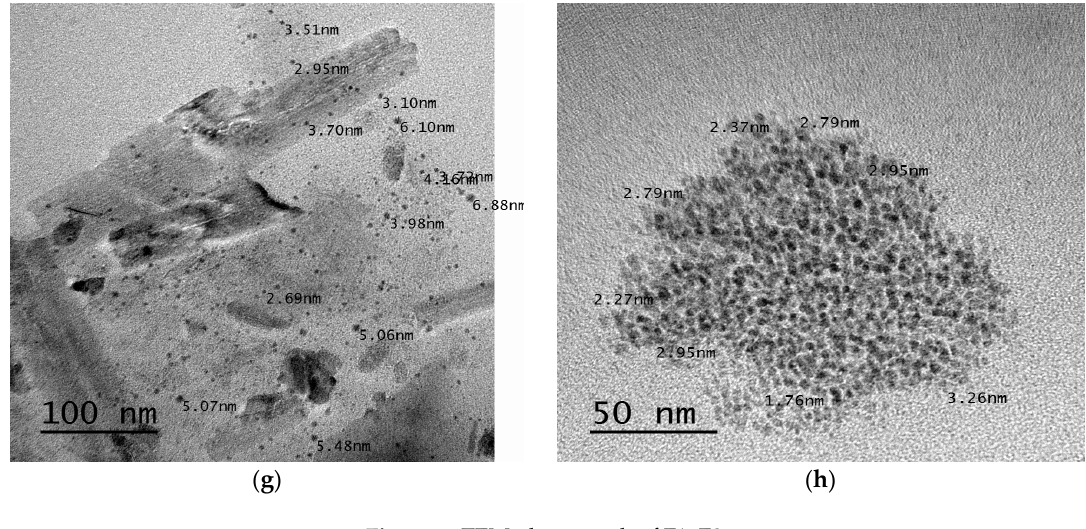
Figure 5. TEM photograph of F1–F8.